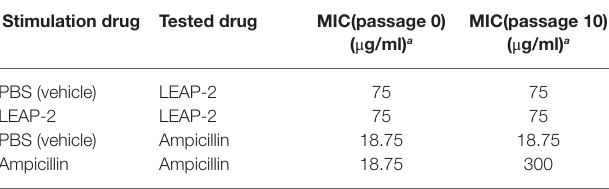
TABLE 4 | Induced drug resistance test of topmouth culter LEAP-2 and ampicillin against Vibrio parahaemolyticus . Stimulation drug Tested drug